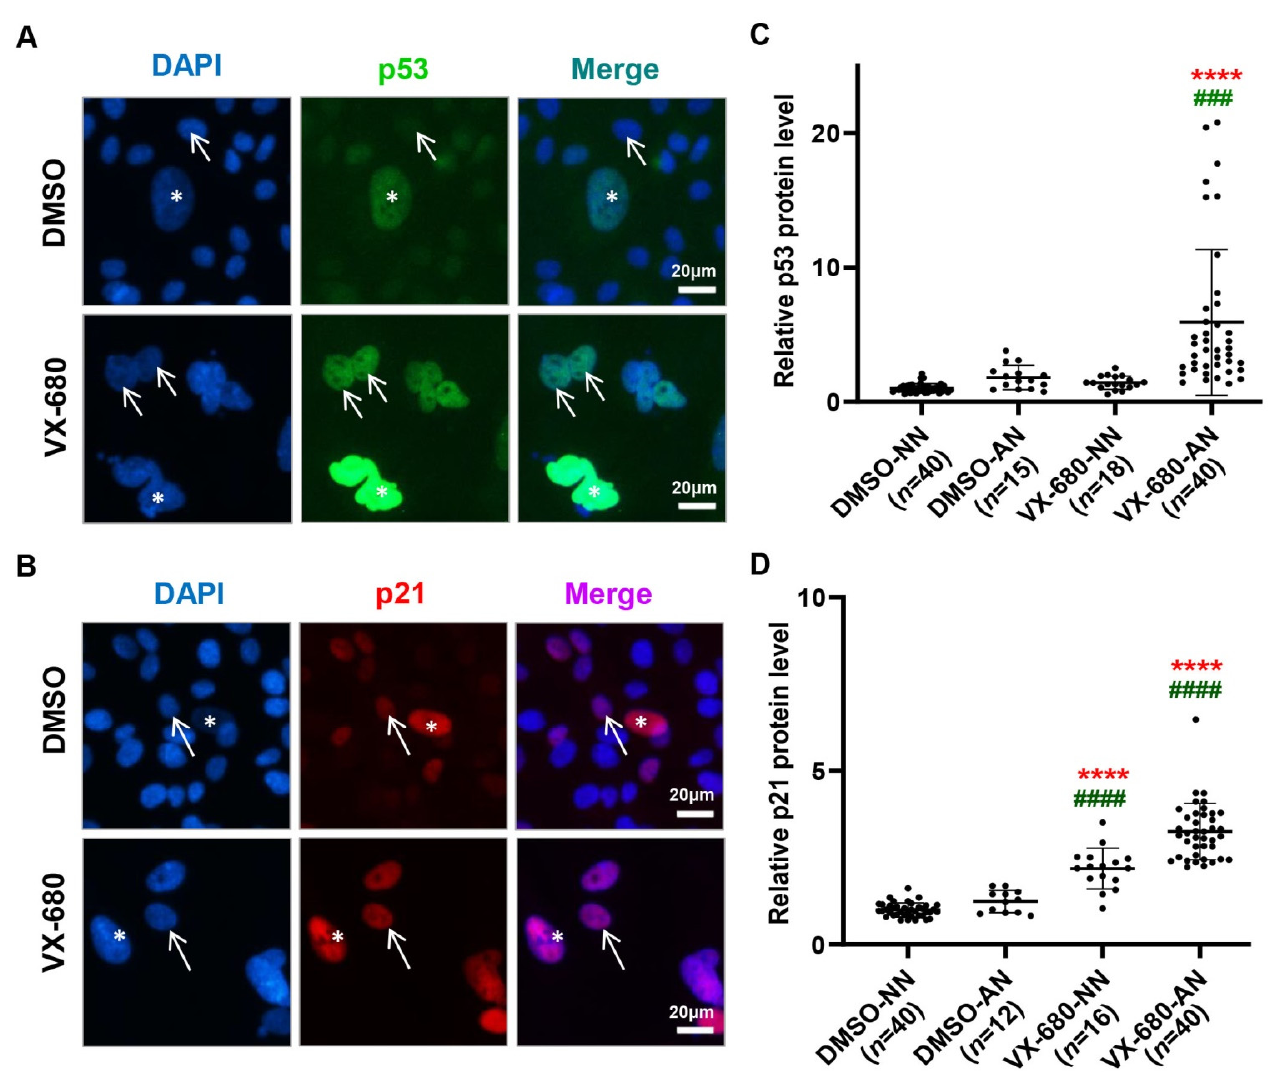
Figure 3. VX-680 induces p53 in AN cells but elevates p21 in both NN and AN cells. RPE-NEO cells were exposed to 300 nM of VX-680 for three days before immunofluorescent analysis for p53 ( A ) and p21 ( B ). The arrows in ( A , B ) denote cells with a normal nucleus (NN) and the stars point to cells with an abnormal nucleus (AN). Rare cells with AN exist naturally in the absence of any treatment. The immunofluorescence intensity of p53 ( C ) and p21 ( D ) was quantified in cells with either an NN or AN separately. The rare cells with an abnormal nucleus in the DMSO group were also analyzed. The data in ( C , D ) were values obtained from one representative independent experiment with a triplicate and were normalized to the average value of the cells with an NN in the control DMSO group. The p values were calculated with the Dunnett test following one-way ANOVA. ****, p < 0.0001 when compared with the DMSO-NN group. ###, p <0.001 and ####, p < 0.0001 when compared with the DMSO-AN group. Black dots in panels C and D indicate the number of replicates used to quantify, p53 and p21 levels respectively. Replicate numbers ( n ) are given in brackets on the x-axis.